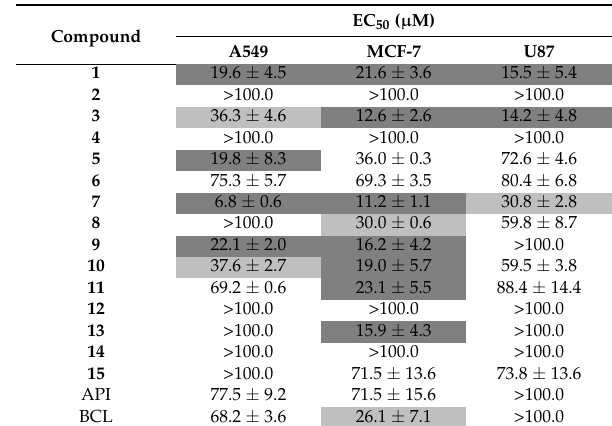
Table 1. Anti-proliferative effect of trihydroxyflavones. White color—EC 50 >50 µ M, light grey—EC 50 <50 µ M, dark grey—EC 50 <25 µ